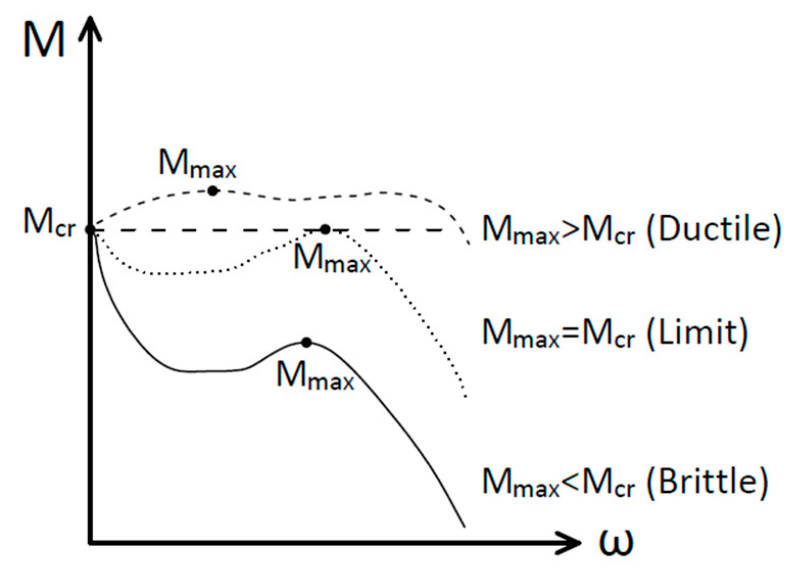
Figure 13. Types of behavior in an experimental test. Bending moment and crack opening.